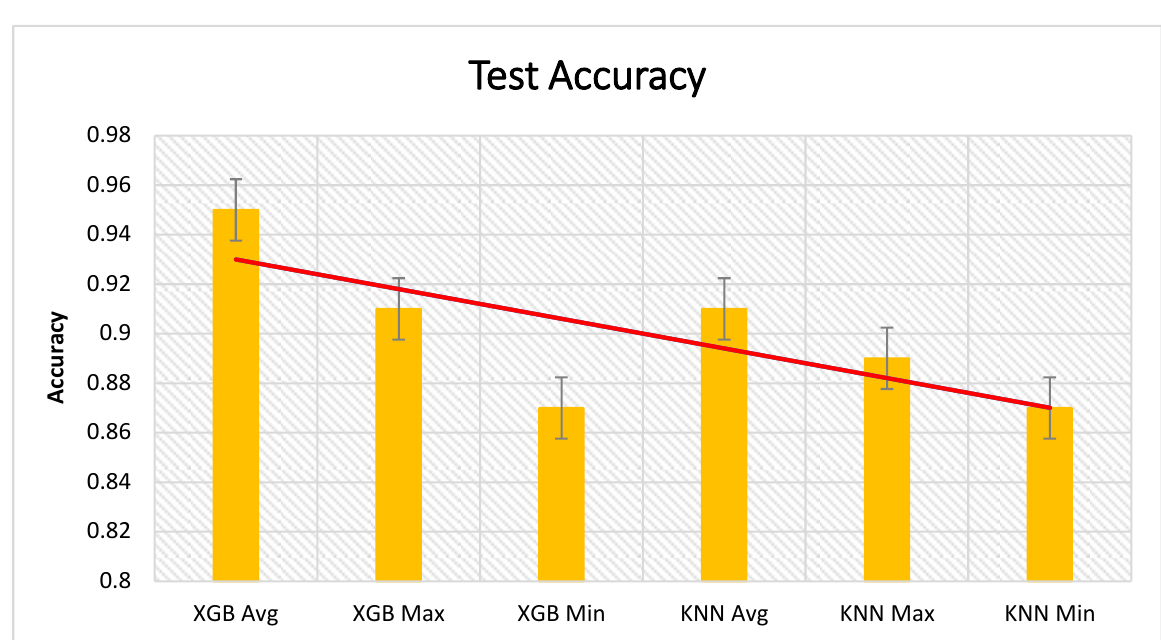
Figure 12. Cross validation of the test accuracy